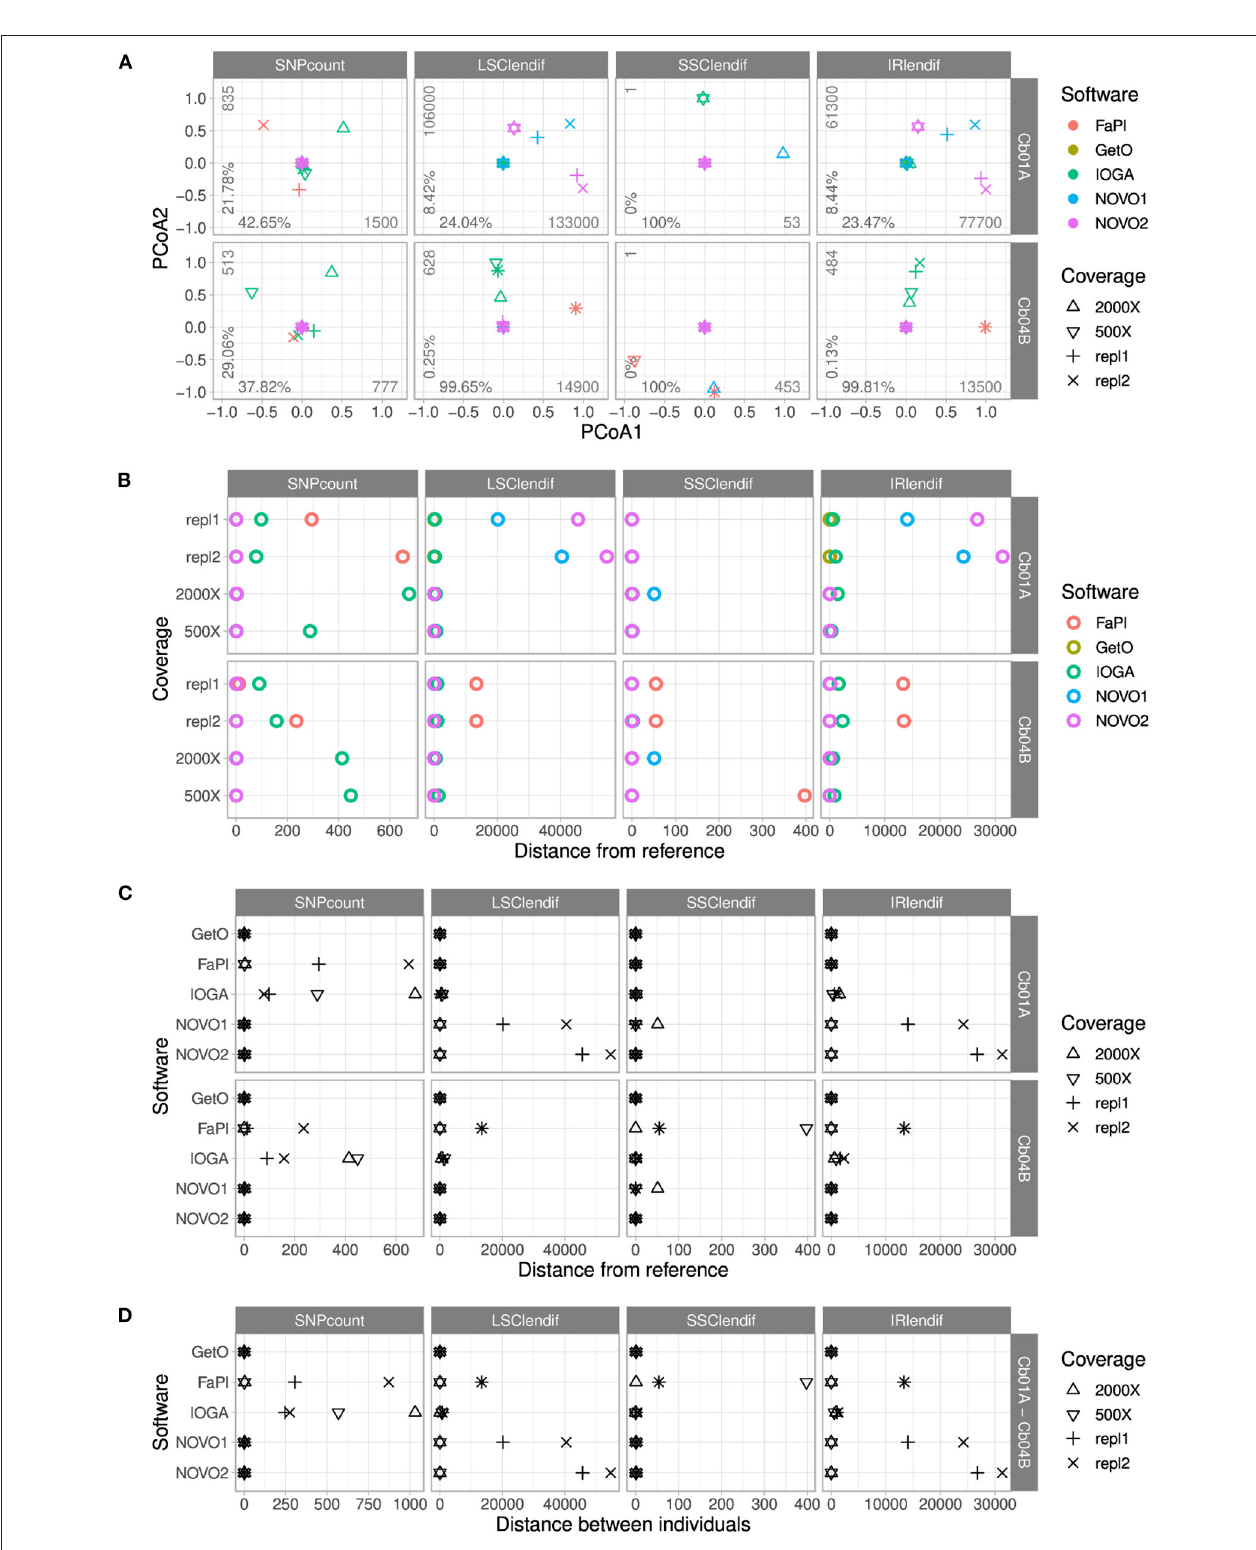
FIGURE 3 | Comparisons of the number of SNPs and the lengths of the four genome regions across the plastid genome assemblies of C. bakuense as generated by different assembly software and levels of sequencing coverage. Subplot (A) displays the results of PCoAs, subplots (B,C) the results of comparisons between a target assembly and the final plastid genome sequence, and subplot (D) the results of assembly comparisons between the two individuals of C. bakuense under study. In